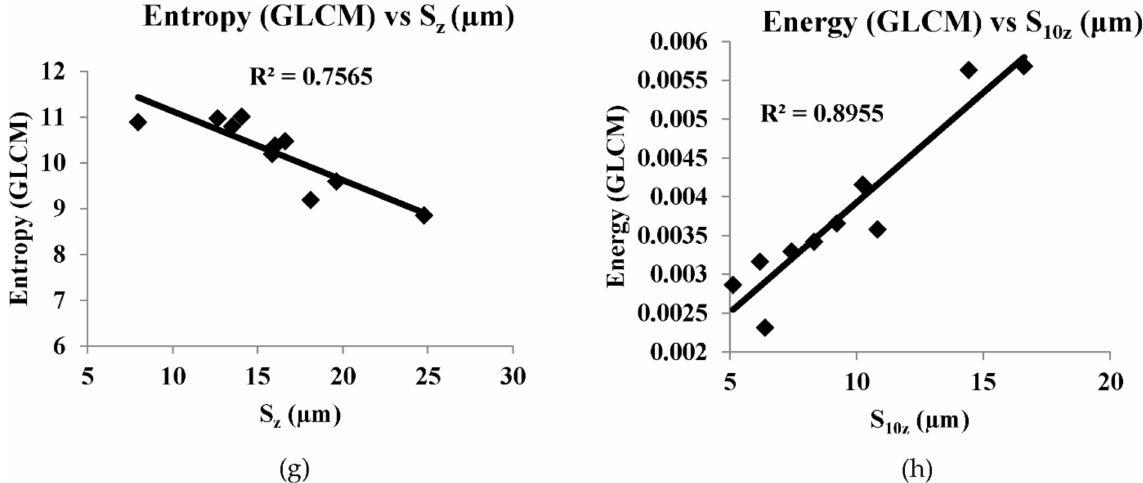
Figure 10. ( a – h ) are correlation plots between characteristic features and roughness parameter with camera setting of f -number of 16 and shutter speed 1/100 s and illumination angle of 45 ◦ .